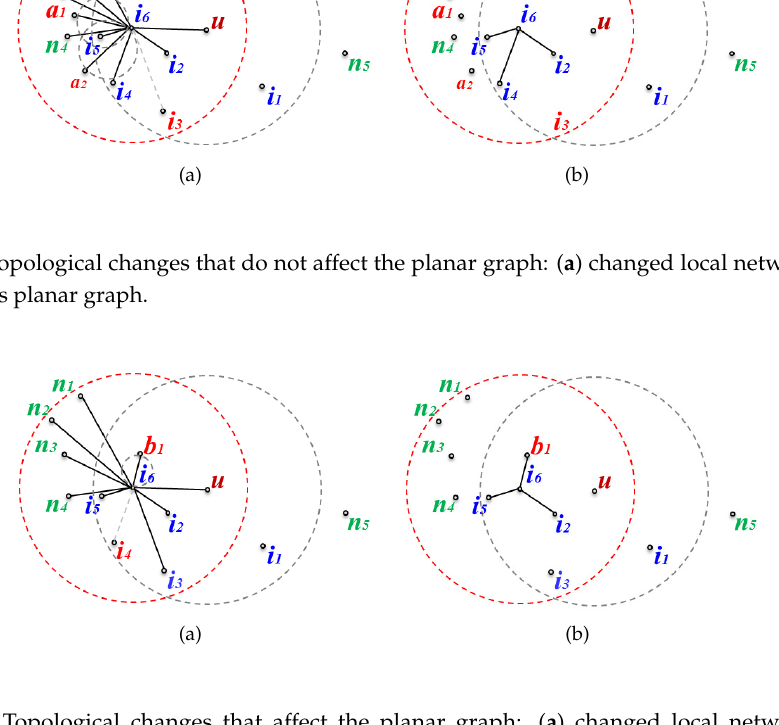
Figure 6. Topological changes that affect the planar graph: ( a ) changed local network graph, and ( b ) (a)’s planar